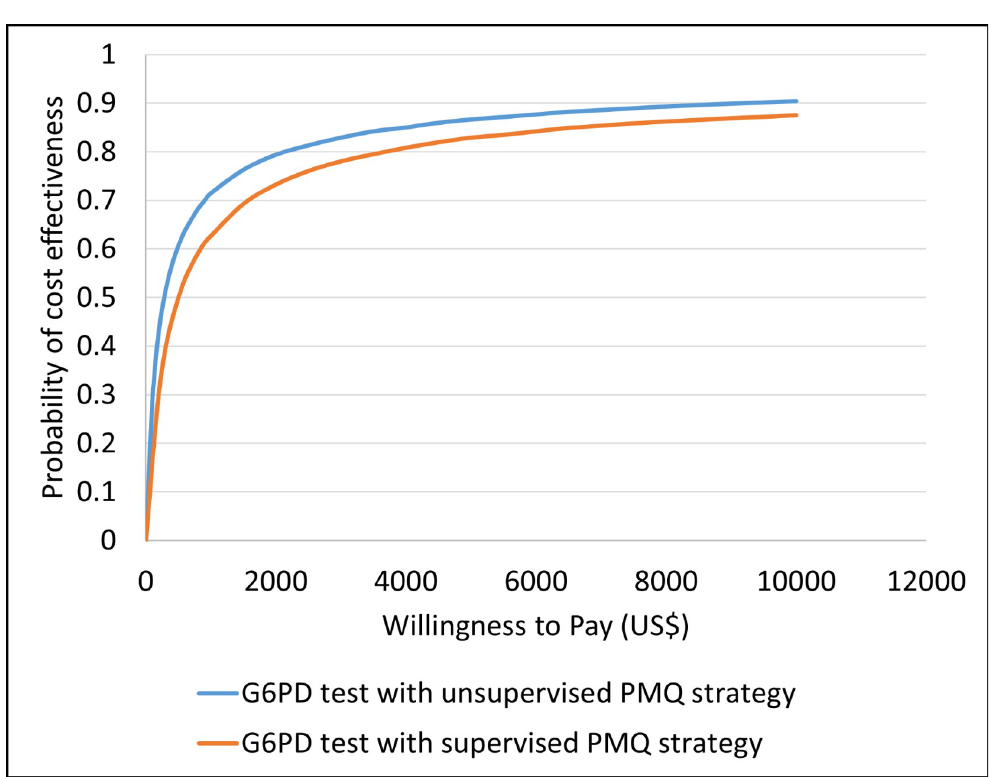
Fig 12. Cost-effectiveness acceptability curve for G6PD test with unsupervised PMQ strategy and G6PD test with supervised PMQ strategy, both compared against the unsupervised PMQ strategy.